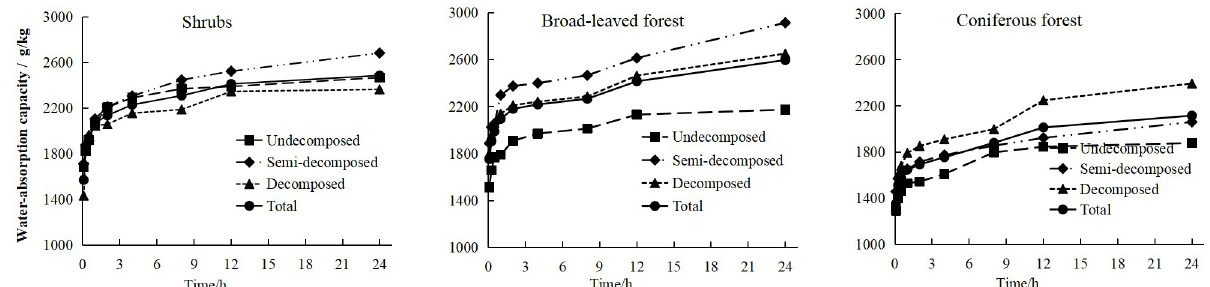
Fig 6. The water-absorption characteristics of litter in the different typical plant communities.